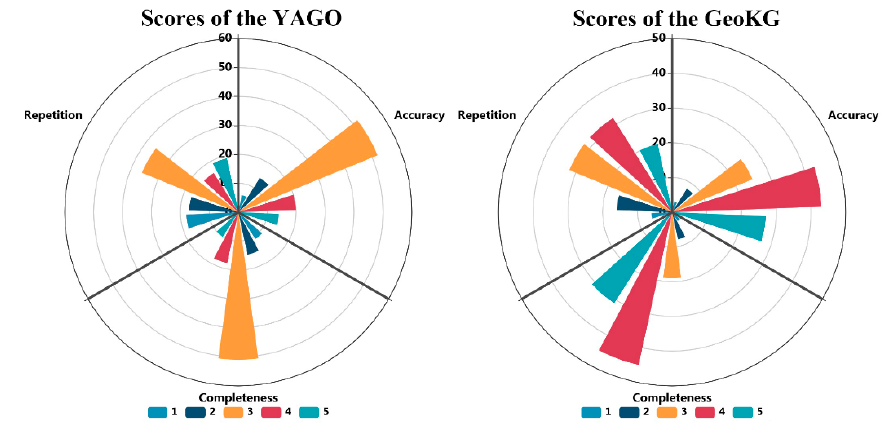
Figure 11. Rose maps of scores of different aspects on the YAGO and the GeoKG.